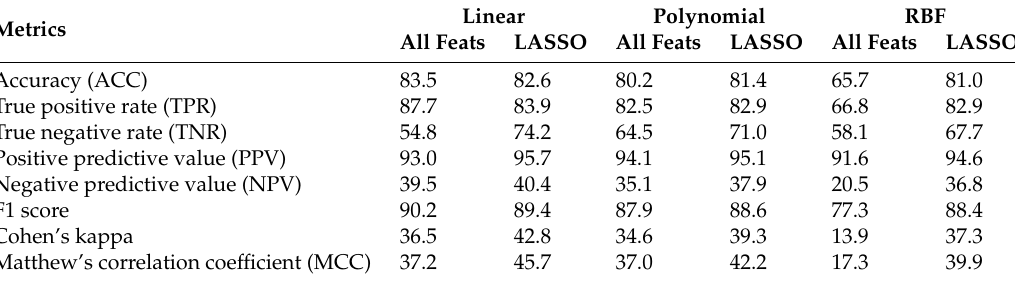
Table 9. Phase 3: Machine learning result against non-age matched